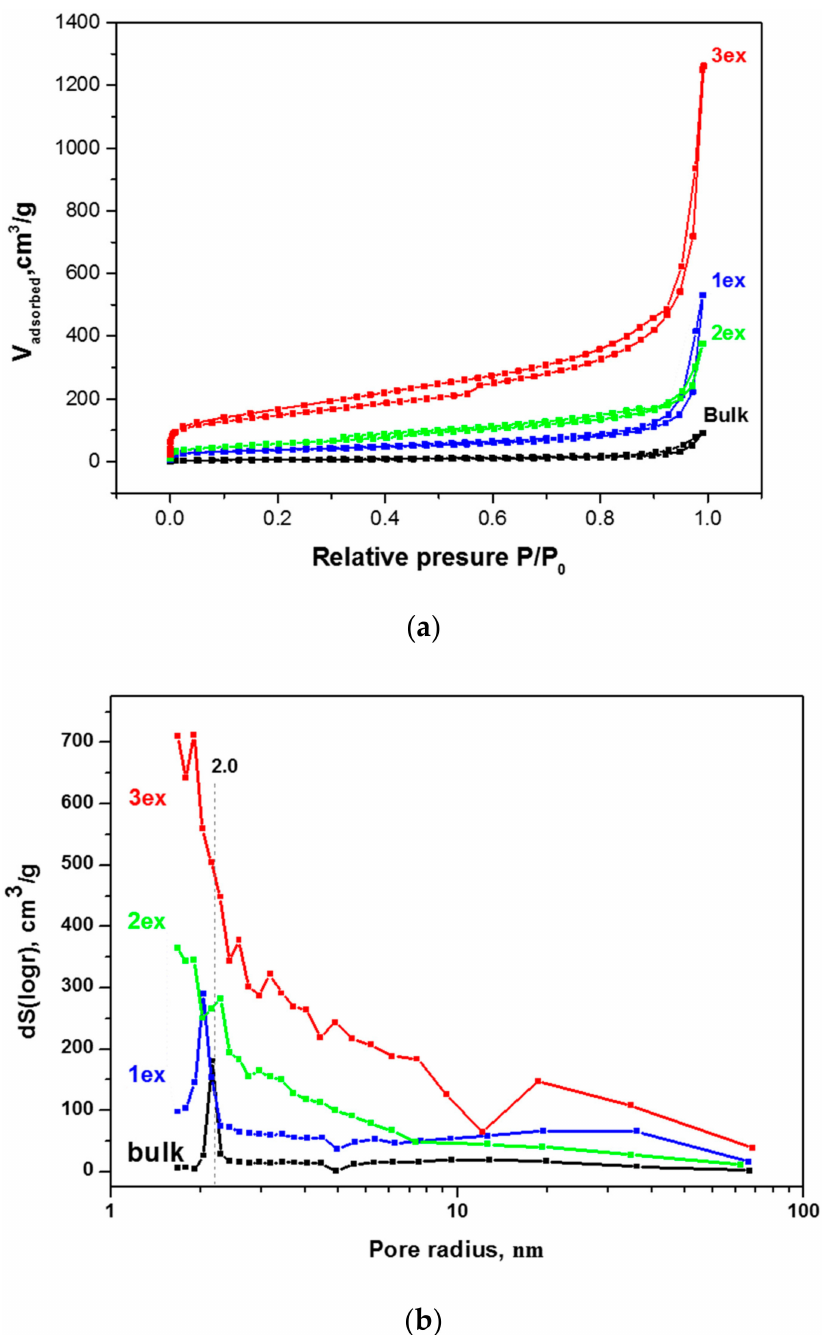
Figure 4. Liquid N 2 (nitrogen) adsorption–desorption isotherms ( a ) and pore size distribution ( b ) of the bulk and exfoliated g-C 3 N 4